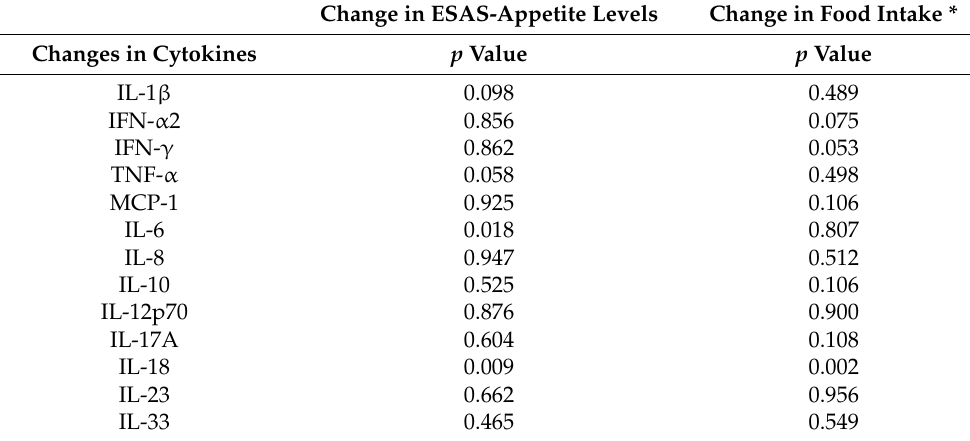
Figure 1. Comparison of changes in IL-18 levels across the ESAS-appetite levels in total population ( n = 191). ESAS, Edmonton Symptom Assessment System; IL-18, interleukin 18. The circles (small values) and stars (extreme values) indicate the outliers. Table 3. Comparison of cytokines changes across the ESAS-appetite changes and food intake changes in total population ( n =